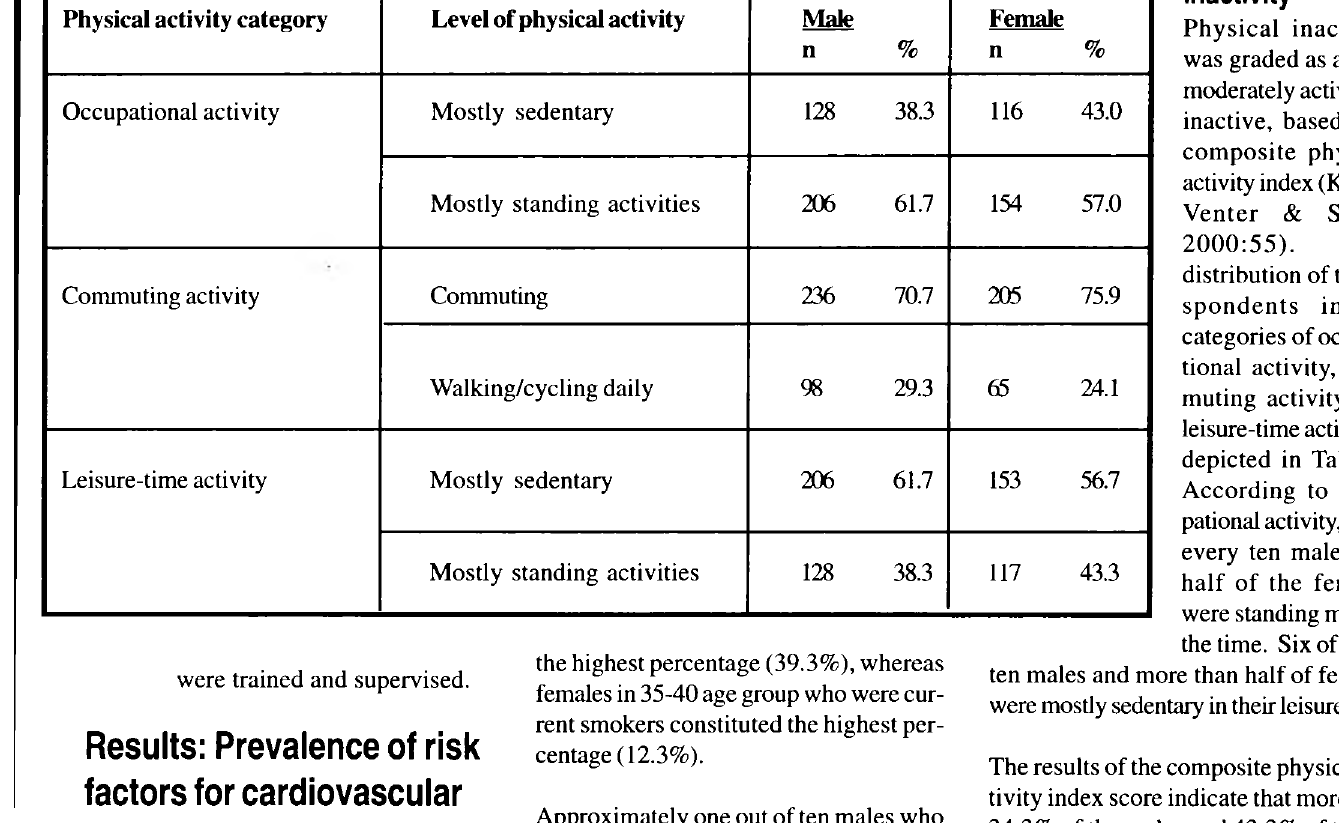
TABLE 1: Distribution of respondents in categories of physical activity